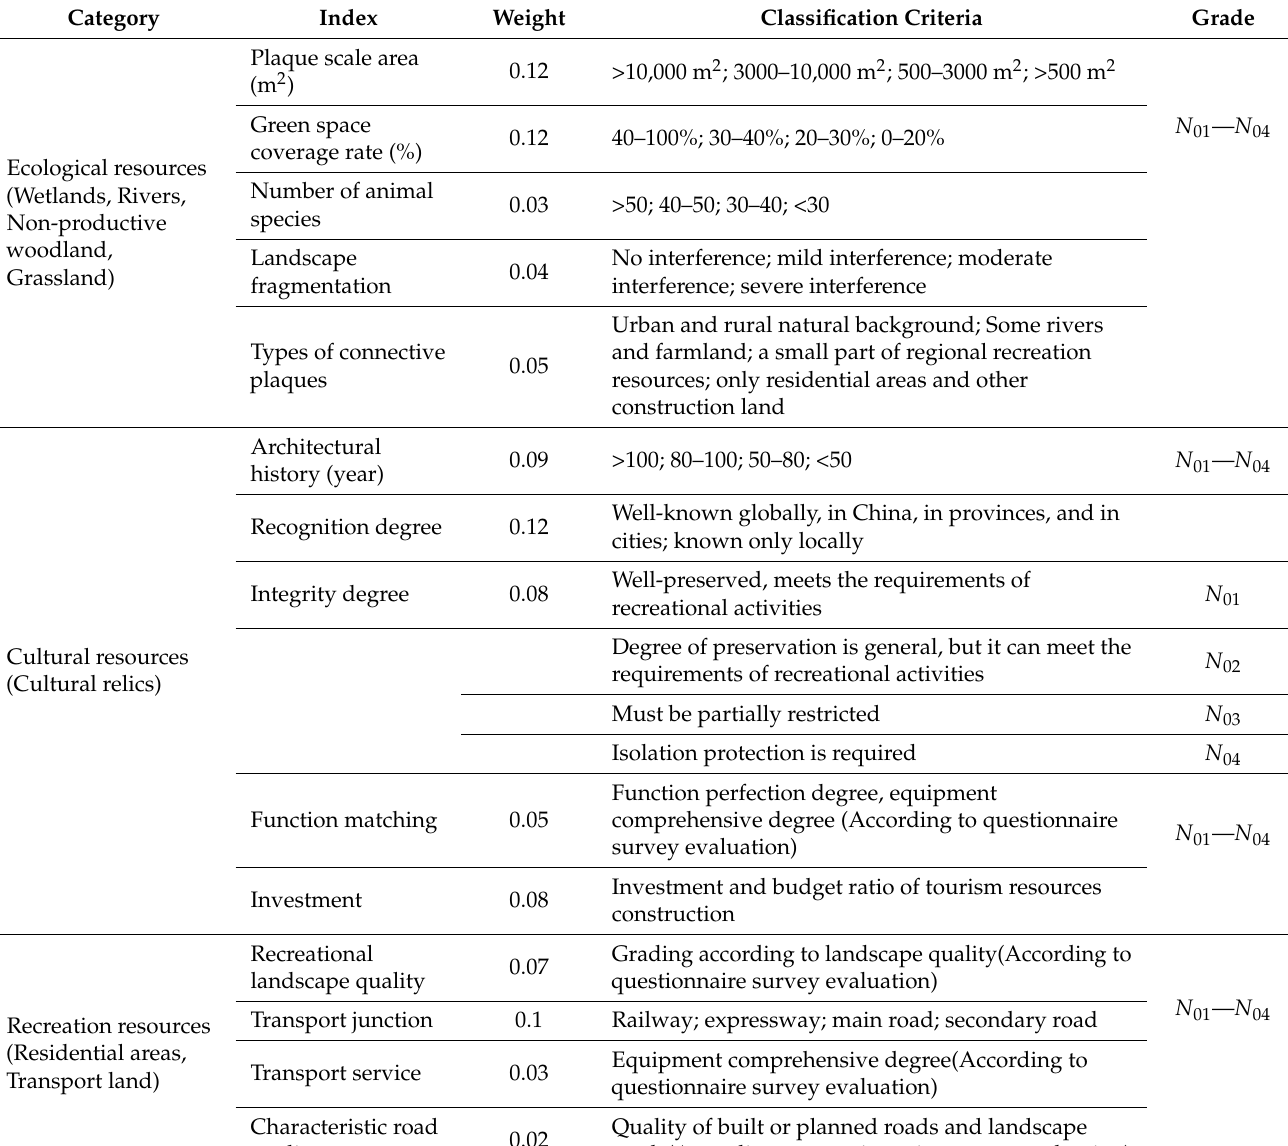
Table 1. Grade criteria for screening relevant elements of the tourism